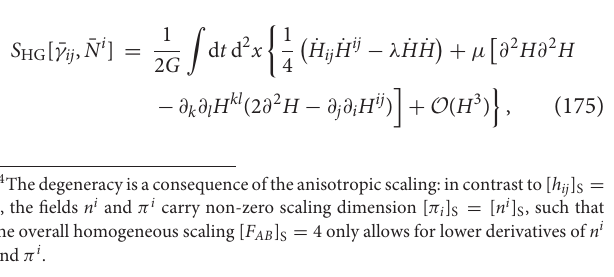
FIGURE 6 | One-loop two-point 1PI diagrams in projectable HG in D dimensions (from [